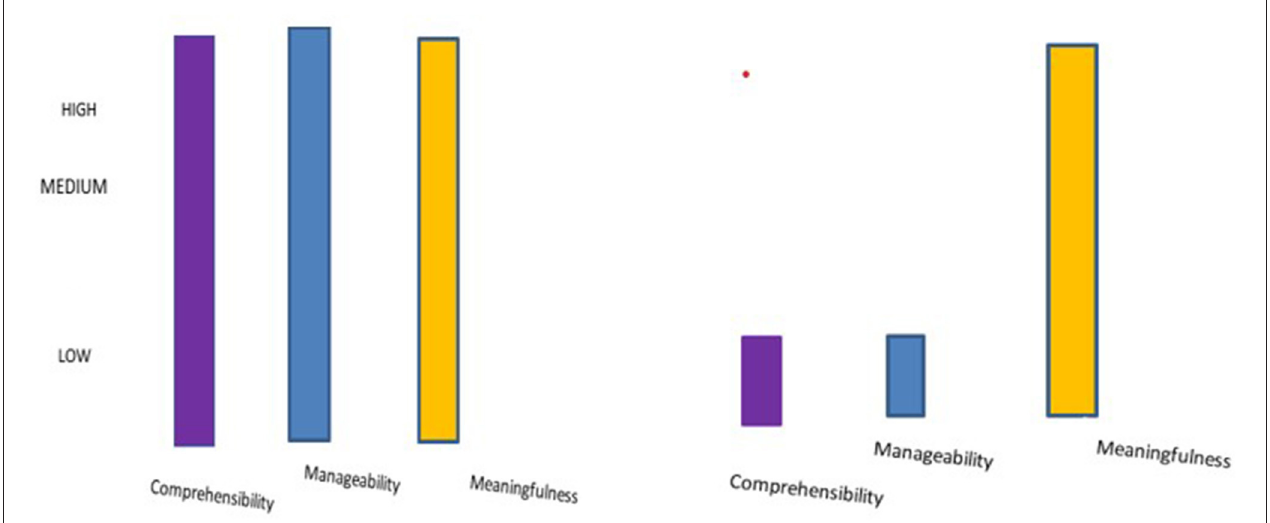
FIGURE 1 | Dimensions of sense of coherence in the narrative and vignette